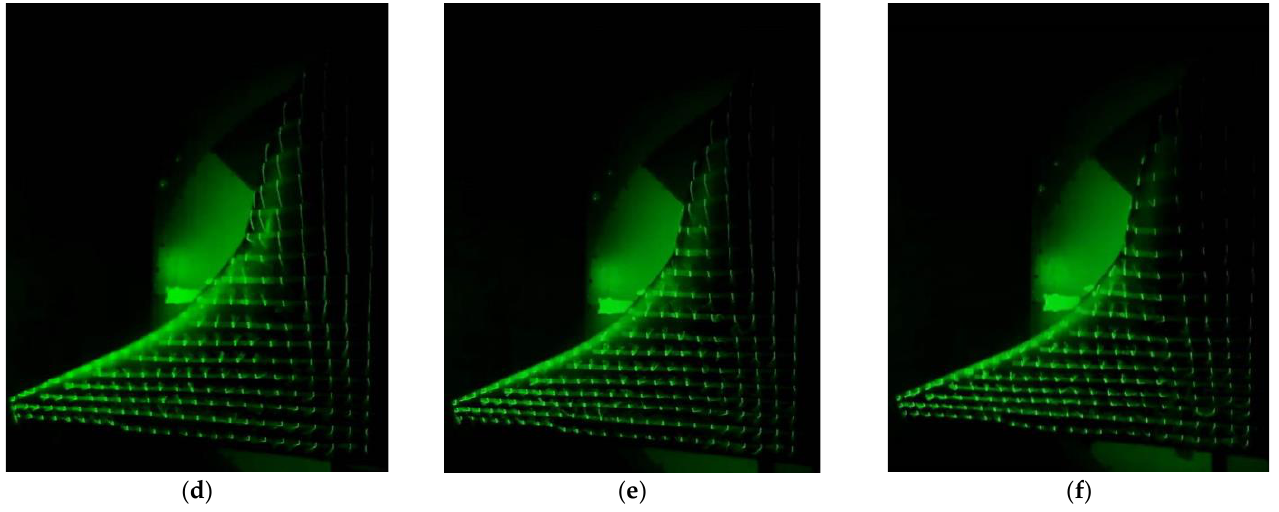
Figure 17 . Experimental surface flow distribution development with angle of attack. (a) α = 8°. (b) Figure 17. Experimental surface flow distribution development with angle of attack. ( a ) α = 8 ◦ . α = 12°. (c) α = 16°. (d) α = 20°. (e) α = 24°. (f) α = 28°. ( b ) α = 12 ◦ . ( c ) α = 16 ◦ . ( d ) α = 20 ◦ . ( e ) α = 24 ◦ . ( f ) α = 28 ◦